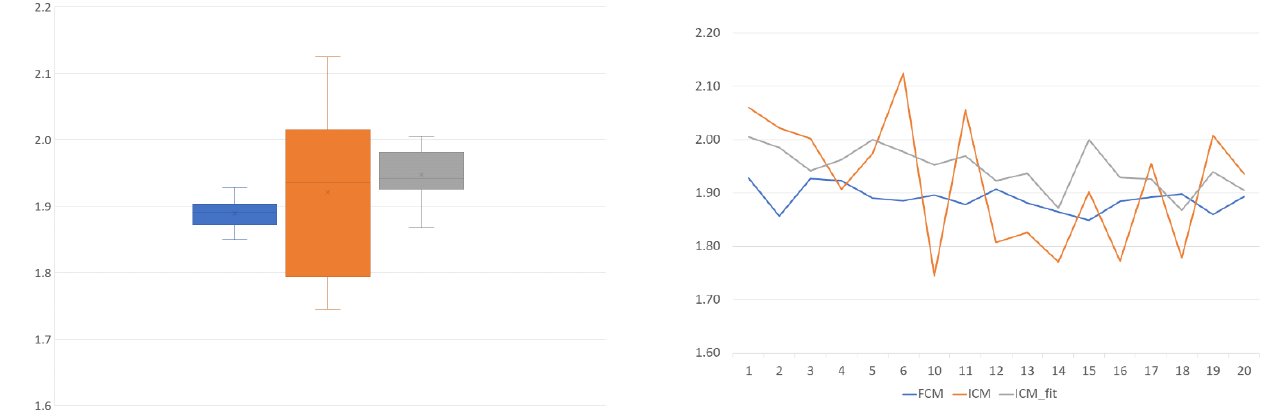
Figure 13. Graphical comparison of the peak ratios for the 17 samples in two equivalent representa- tions: The datasets are marked with the same color on both plots. Peak ratio is the ratio of the DNA content at the 4N peak to the DNA content of the 2N peak. This theoretically equals 2.0 because, during mitosis, a normal body cell first replicates/doubles its DNA content before dividing into two new daughter cells.